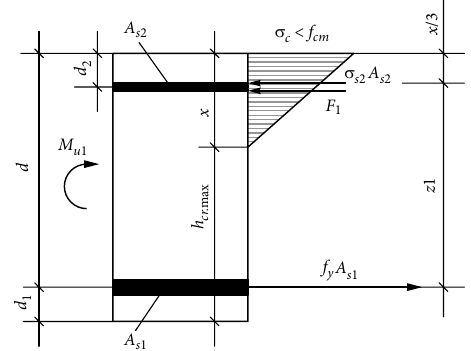
Fig. 4. Estimated state of stress when tensile reinforcement reaches yielding stress